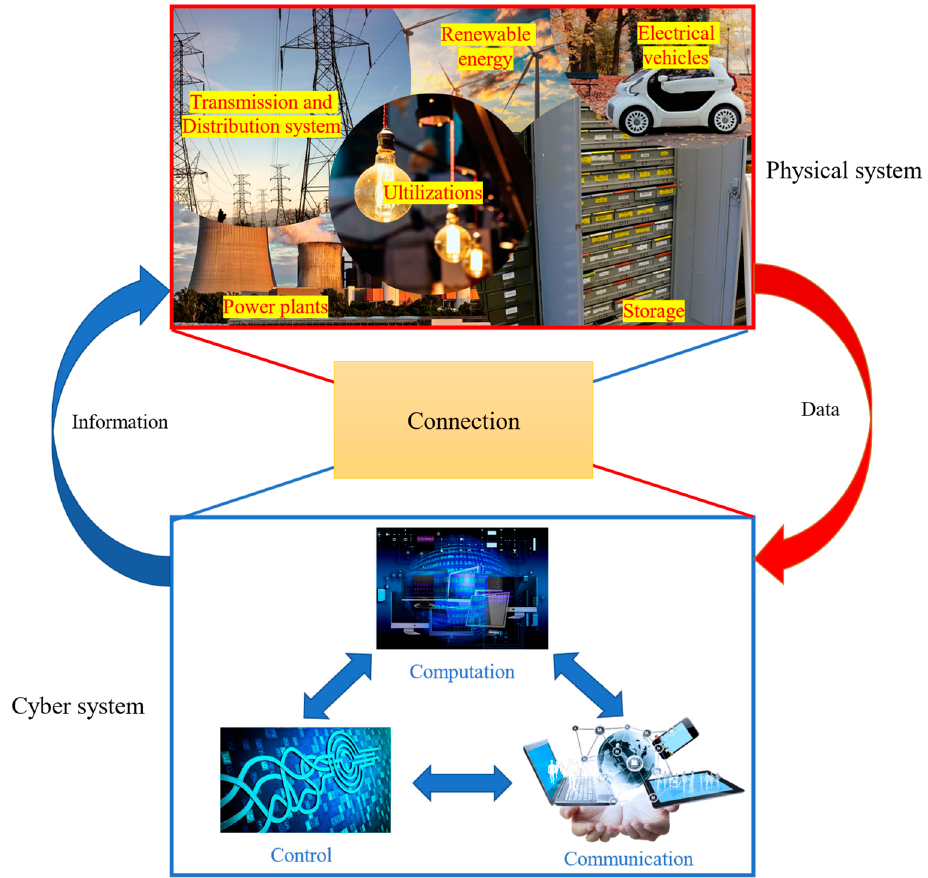
Figure 2. Structure of CPEPS.